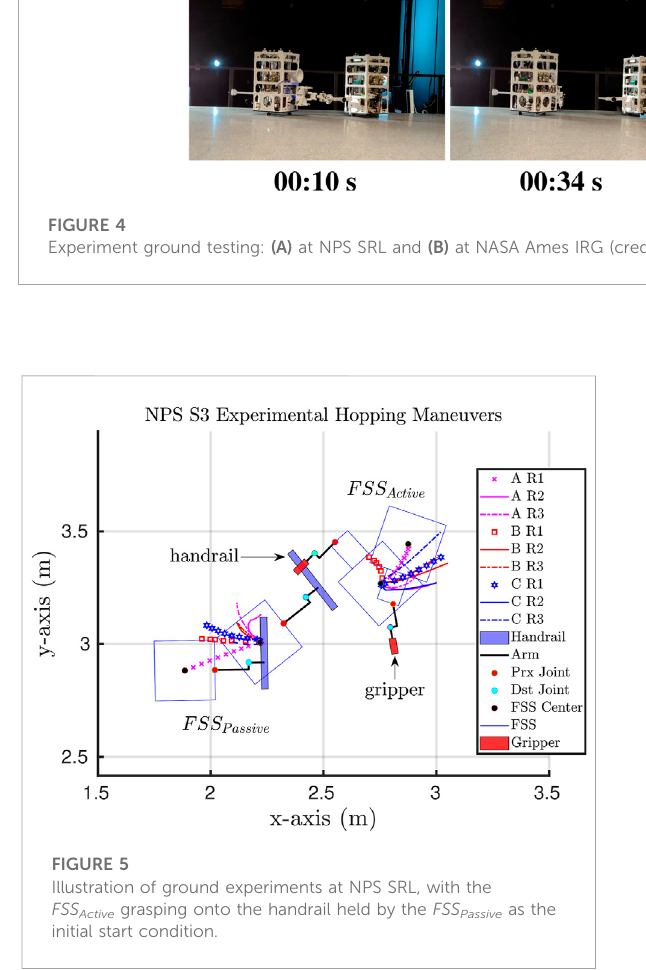
From Figure 6, the x- and y-displacement vs. time plots depict the trajectory of the FSS active (line) compared to the FSS passive (symbol) vehicle. After separation, the active and passive FSS vehicles are shown to move in approximately opposite directions.